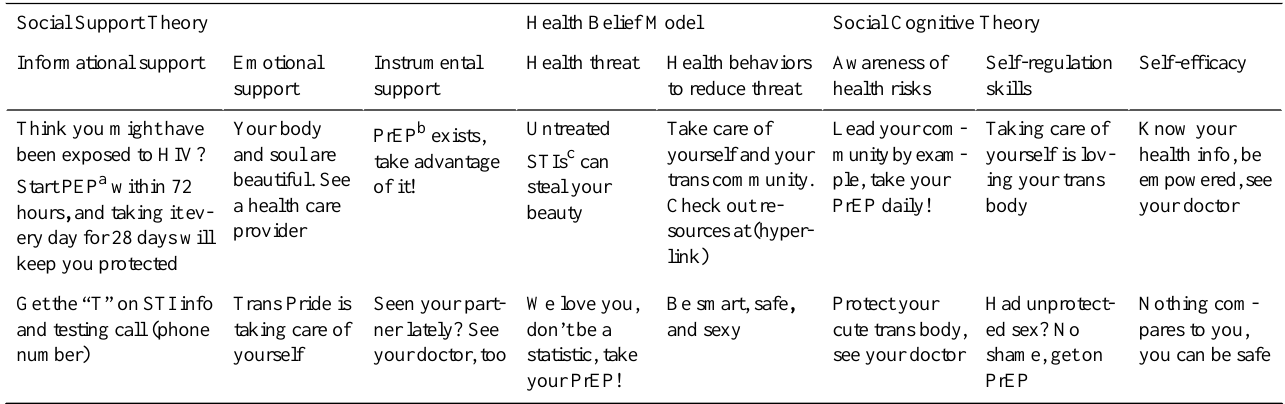
Figure 1. TechStep WebApp components and the Information, Motivation, Behavior model. PrEP: pre-exposure prophylaxis.